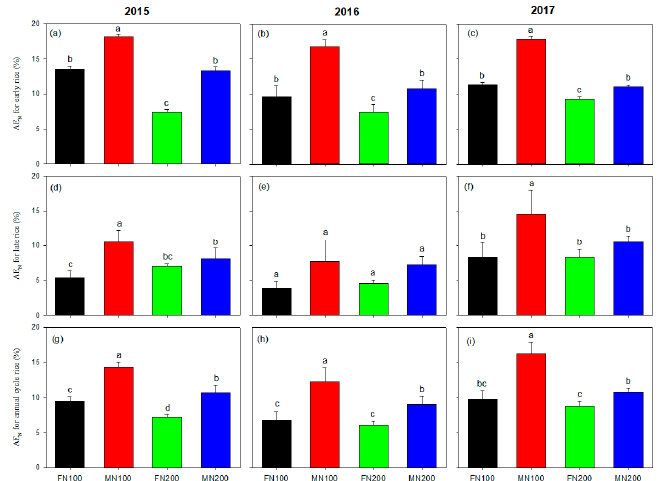
Figure 2. Total N uptake for early ( a – c ), late ( d – f ), and annual cycle ( g – i ) rice from 2015 to 2017. FN 0 represents winter fallow without N application in rice seasons as a check, MN 100 represents vetch cover cropping with 100 kg N ha − 1 each rice season, FN 100 represents winter fallow with 100 kg N ha − 1 each rice season, MN 200 represents vetch cover cropping with 200 kg N ha − 1 each rice season, and FN 200 represents winter fallow with 200 kg N ha − 1 each rice season. The data shown in the panels are averages of the three replications for individual treatments. Vertical bars represent the standard errors. Di ff erent lowercase letters represent the significant di ff erences at p < 0.05.